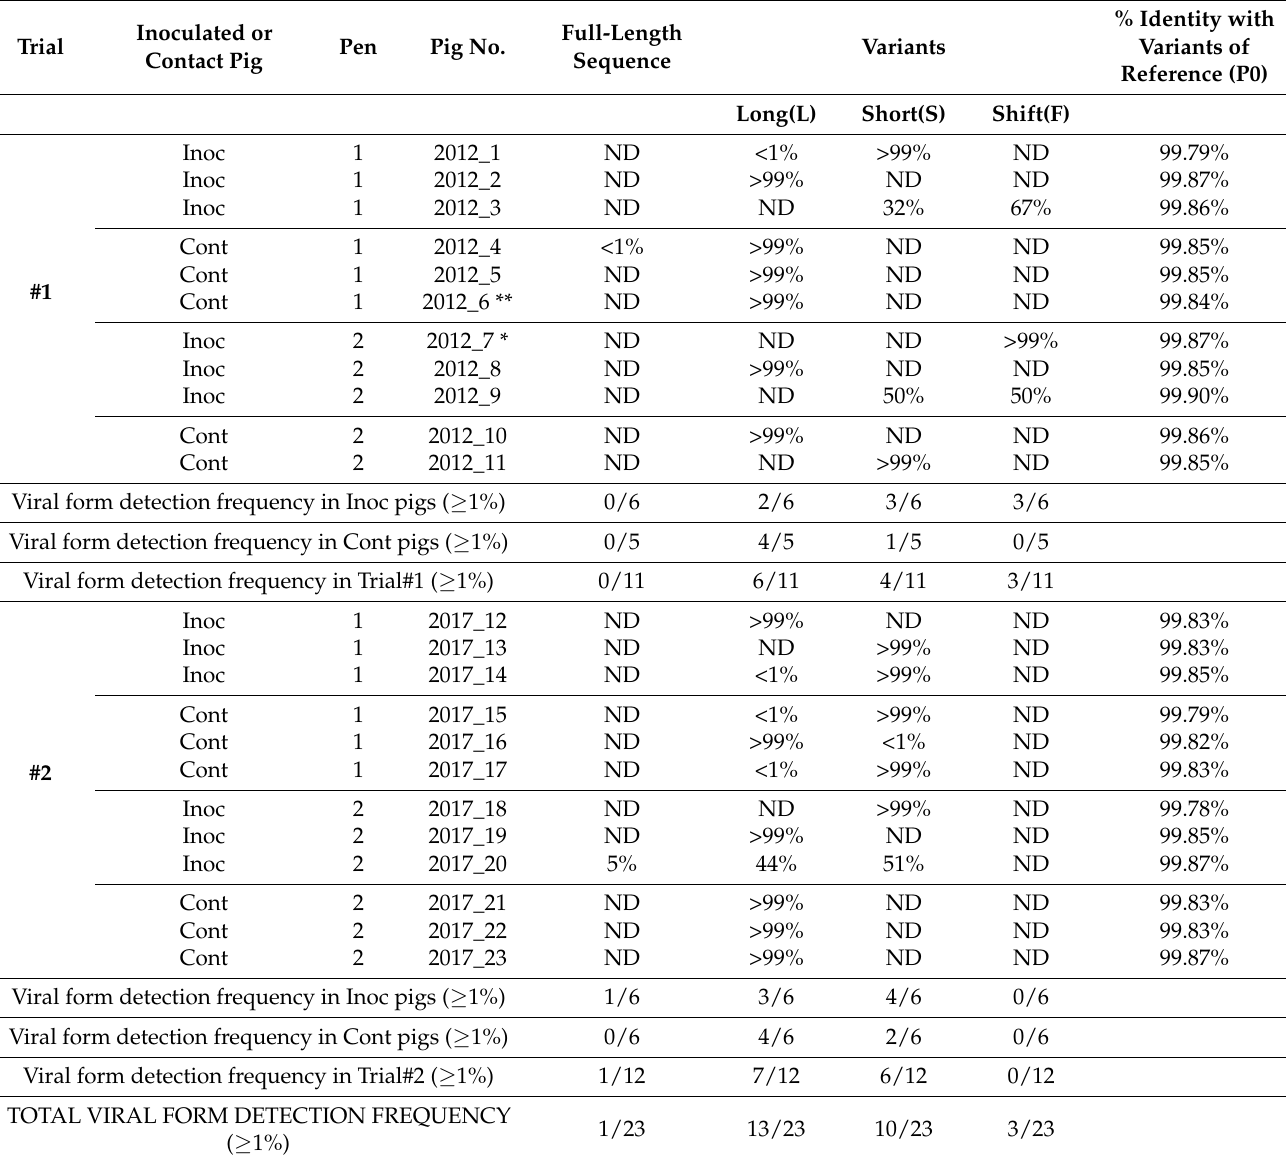
Table 4. Selection of PRRSV forms (full-length sequence and variants) from Porcilis ® PRRS vaccine after vaccinations and transmissions during Trial#1 and